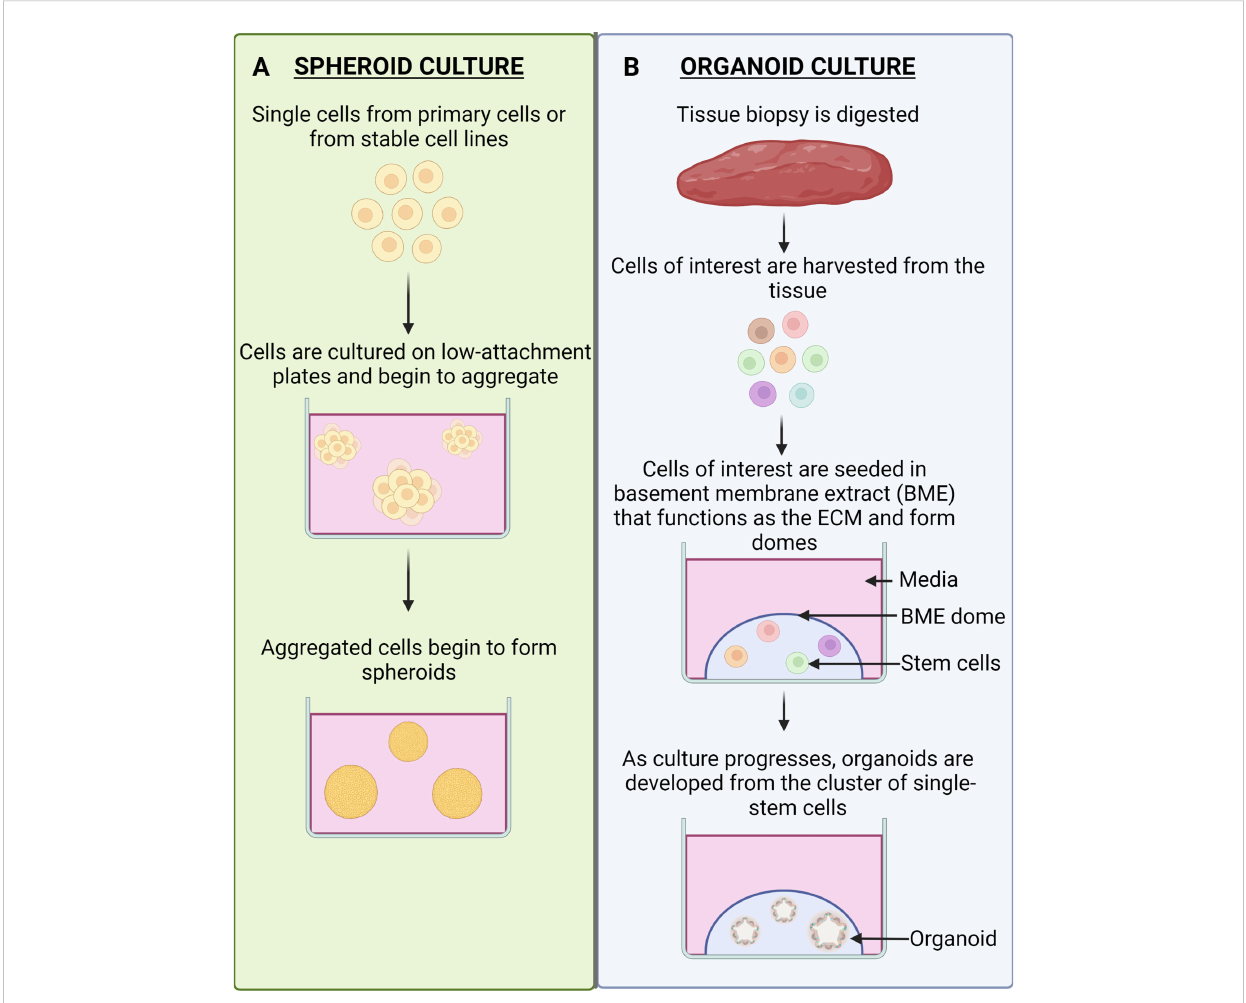
FIGURE 3 Spheroid Culture vs. Organoid Culture. (A) Spheroid culture. Spheroids are cultured by obtaining single cells from primary cells or from stable cell lines. The cells are naturally able to form aggregates and can do so in suspension culture. The aggregates will become more de fi ned spheroids as the culture progresses. (B) Organoid culture. Tissue that is biopsied from patients will be digested into cells and the cells of interest can be harvested. These cells are then seeded in a ECM-mimicking substrate (BME), which will result in the formation of domes. The stem cells will